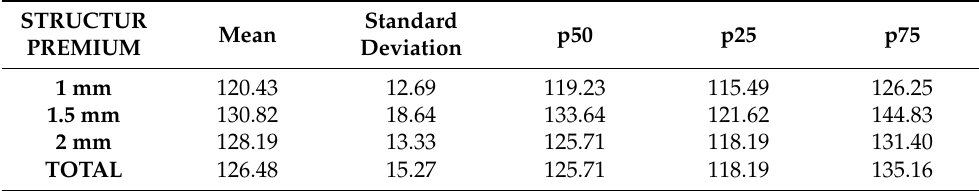
Table 4. Flexural strength vs. thickness (Structur